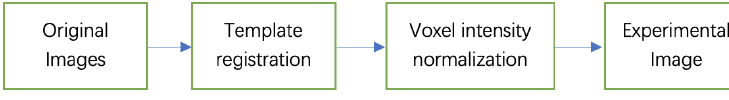
Figure 1. The flowchart of image